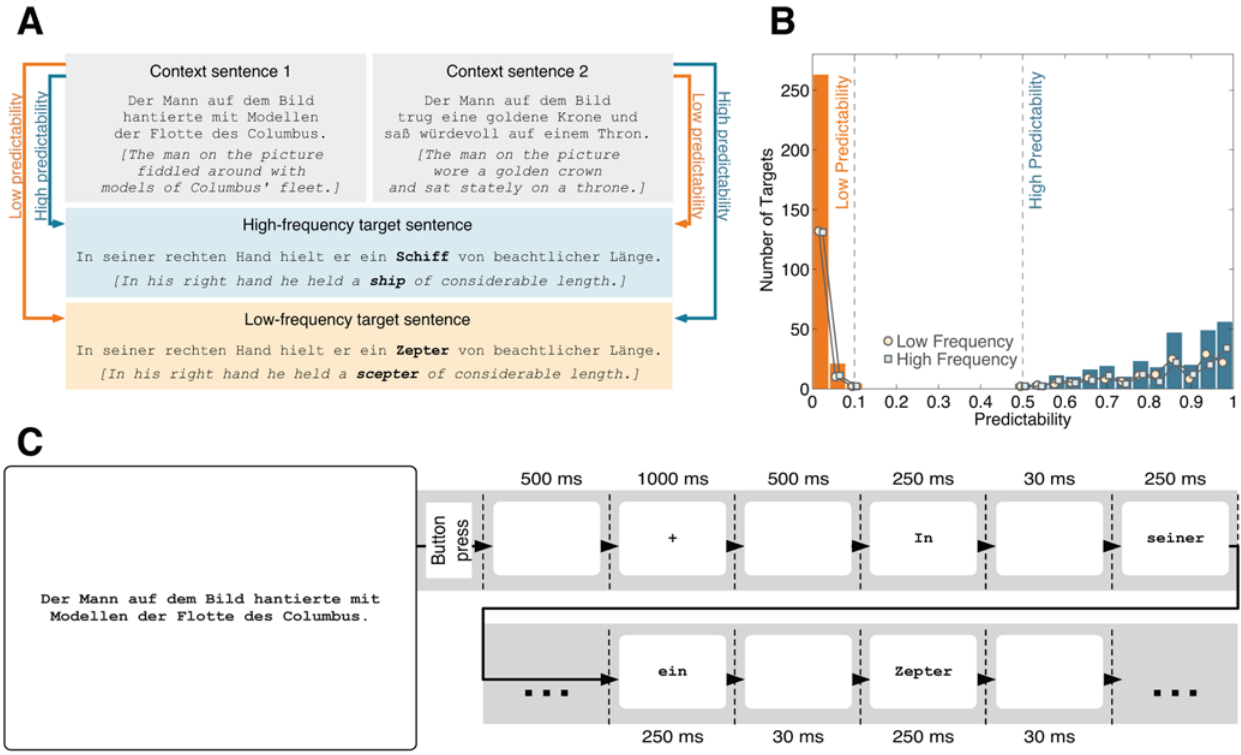
Figure 1. Stimuli and procedure. (A) Stimulus example. High ( ship ) and low frequency ( scepter ) targets were embedded in a neutral sentence frame. Two context sentences triggered low or high predictability of target words. (B) Distribution of predictability values. Bars illustrate the distribution of target predictability across the stimulus material. Low predictability targets (orange) include cloze probabilities no larger than .1. High predictability words (blue) comprise cloze values of at least .5. Lines reflect the dispersion of predictability norms within low (light orange circles) and high frequency (light blue squares) categories. Note that the entire corpus comprises a total of 576 predictability values, since each of the 144 sentence units involves a low and a high frequency target that both serve as low and as high predictability word. (C) Presentation sequence. A context sentence was fully displayed until participants pressed a button. After a fixation cross, the neutral sentence was presented word by word at monitor center. Each word was displayed for 250 ms and followed by a 30 ms blank screen.